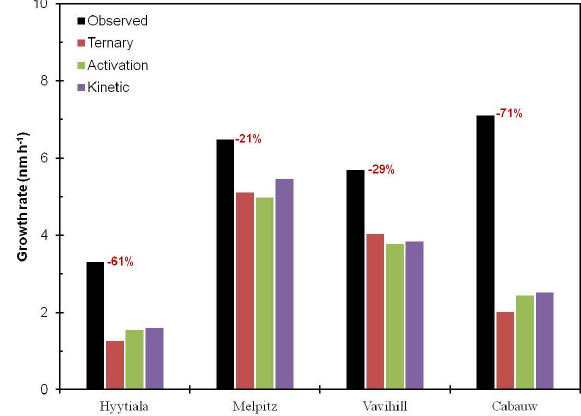
Figure 6. Comparison of predicted vs. observed monthly median growth rates of particles (less than 20 nm) during May 2008. The numbers in red color indicate the (ternary simulation) prediction error.